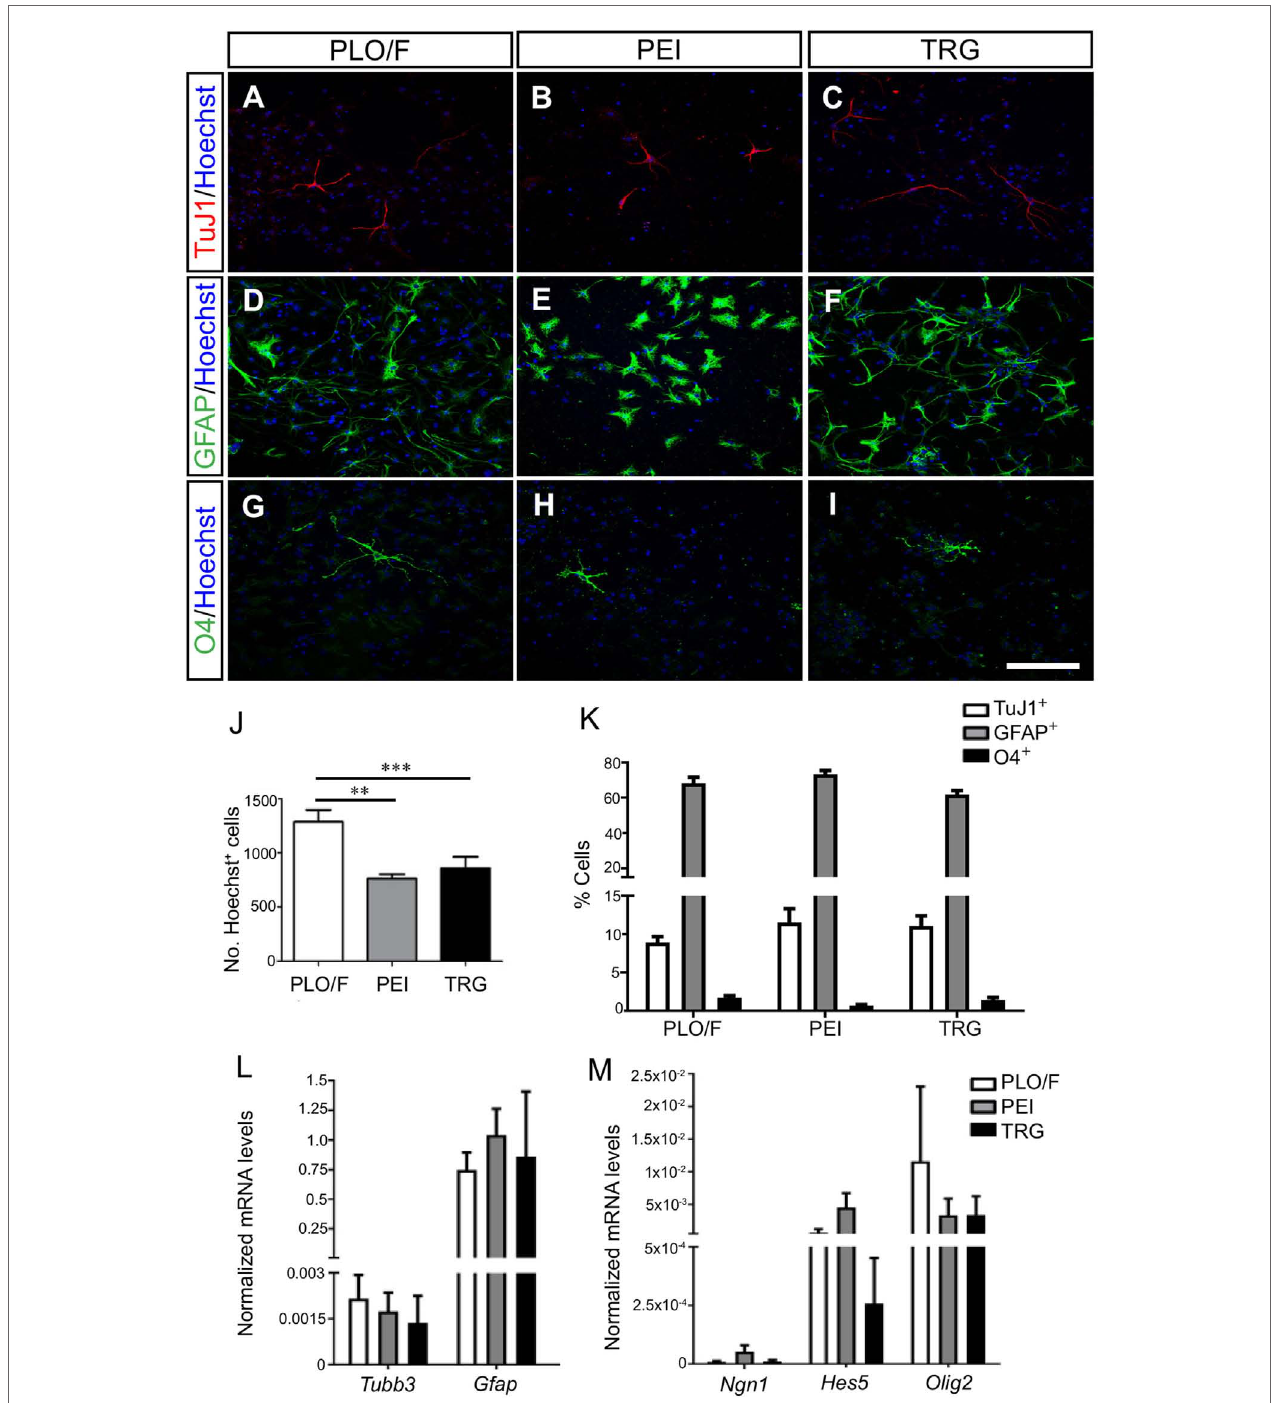
FigUre 3 | Multi-lineage differentiation and transcription factor expression of aOBscs grown on Trg . The aOBSCs were grown as neurospheres, dissociated and seeded on PLO/F-, PEI-, and TRG-coated coverslips for 3–4 days in serum-free medium. They gave rise to the three major cell types of the CNS: neurons (a–c) , astrocytes (D–F) , and oligodendrocytes (g–i) , which were detected using antibodies against β -III tubulin (TuJ1), GFAP, and O4. Graph (J) shows that there was a significant decrease in the total number of cells grown on PEI- (41%) and TRG-coated (33.9%) coverslips compared to PLO/F-coated coverslips. There were no significant differences in the percentage of the three cell fates grown under all three conditions (K) . The expression levels of Tubb3 and Gfap transcripts were similar in the three conditions (l) . The cell lineage-related transcripts Ngn1 , Hes5 , and Olig2 were expressed with not significant changes between controls and TRG (M) . The bars represent the mean ± SEM ( n = 4–13 cultures per condition). Statistical analyses were performed using one-way ANOVA and Tukey’s test, ** P < 0.01, *** P < 0.001. Scale bar [shown in (i) ] = 100.5 μ